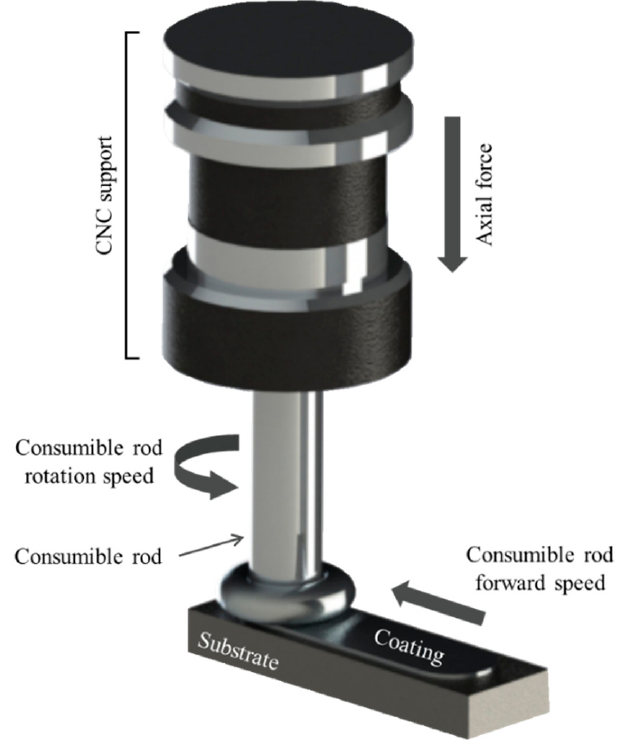
Figure 1. A schematic illustration of the friction coating process applied to the deposition with the identification of the main process parameters.